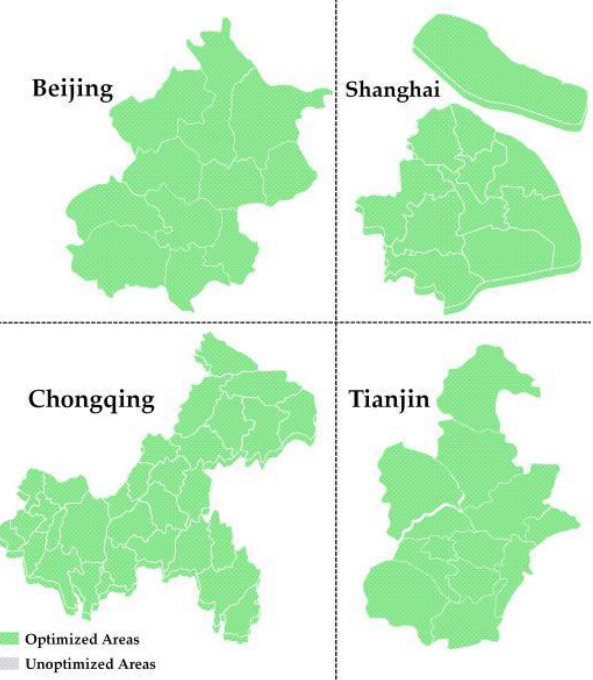
Figure 5. Spatio-temporal evolution pattern of LUE_Env in Beijing, Shanghai, Chongqing, and Tianjin.